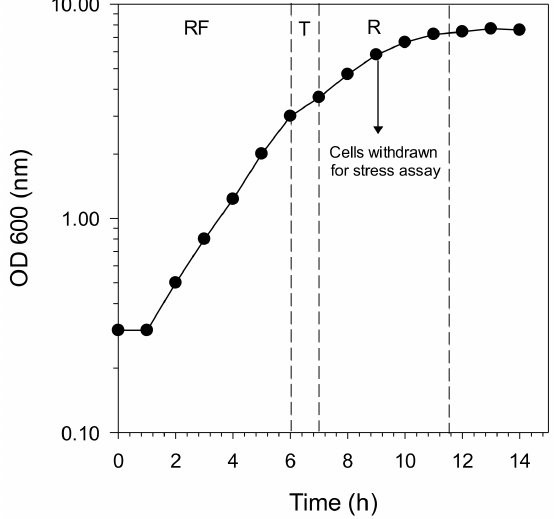
Figure 1. Growth curve of the Saccharomyces cerevisiae SKQ2n cultured in synthetic medium YNB (Yeast Nitrogen Base) with 2% glucose as the sole carbon and energy source and monitored by optical density (OD). Dotted lines represent transitions from one physiological state to another. RF: respiro-fermentative phase; T: transition phase and R: respiratory